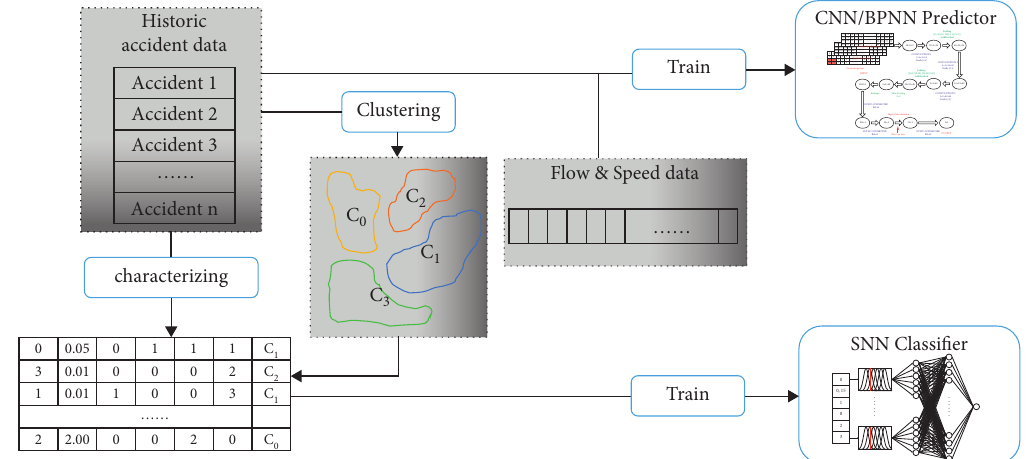
Figure 2: 3-stage model for accident post-impact prediction–training